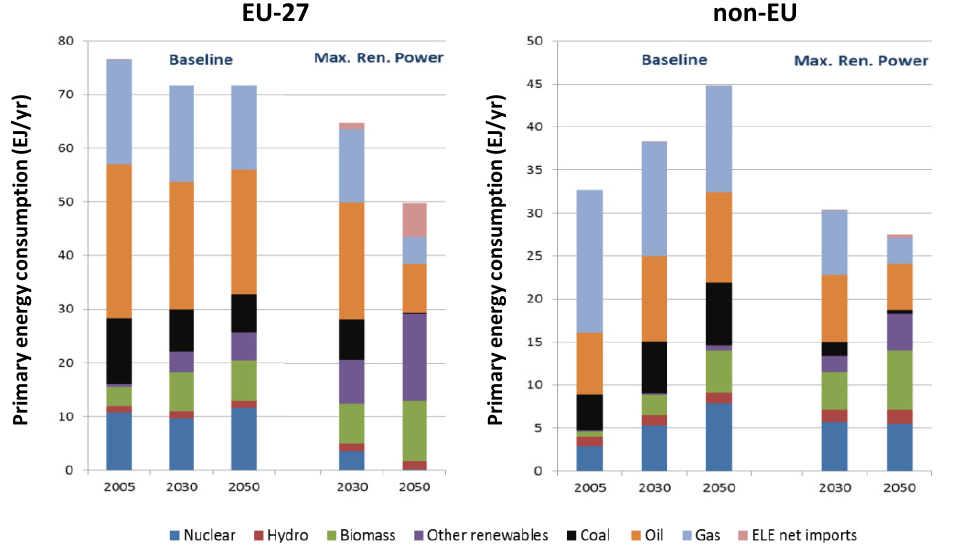
Figure 4. Demand for primary energy in EU-27 and non-EU regions in the Baseline and the Maximum Renewable Power scenarios. Source: REMix and